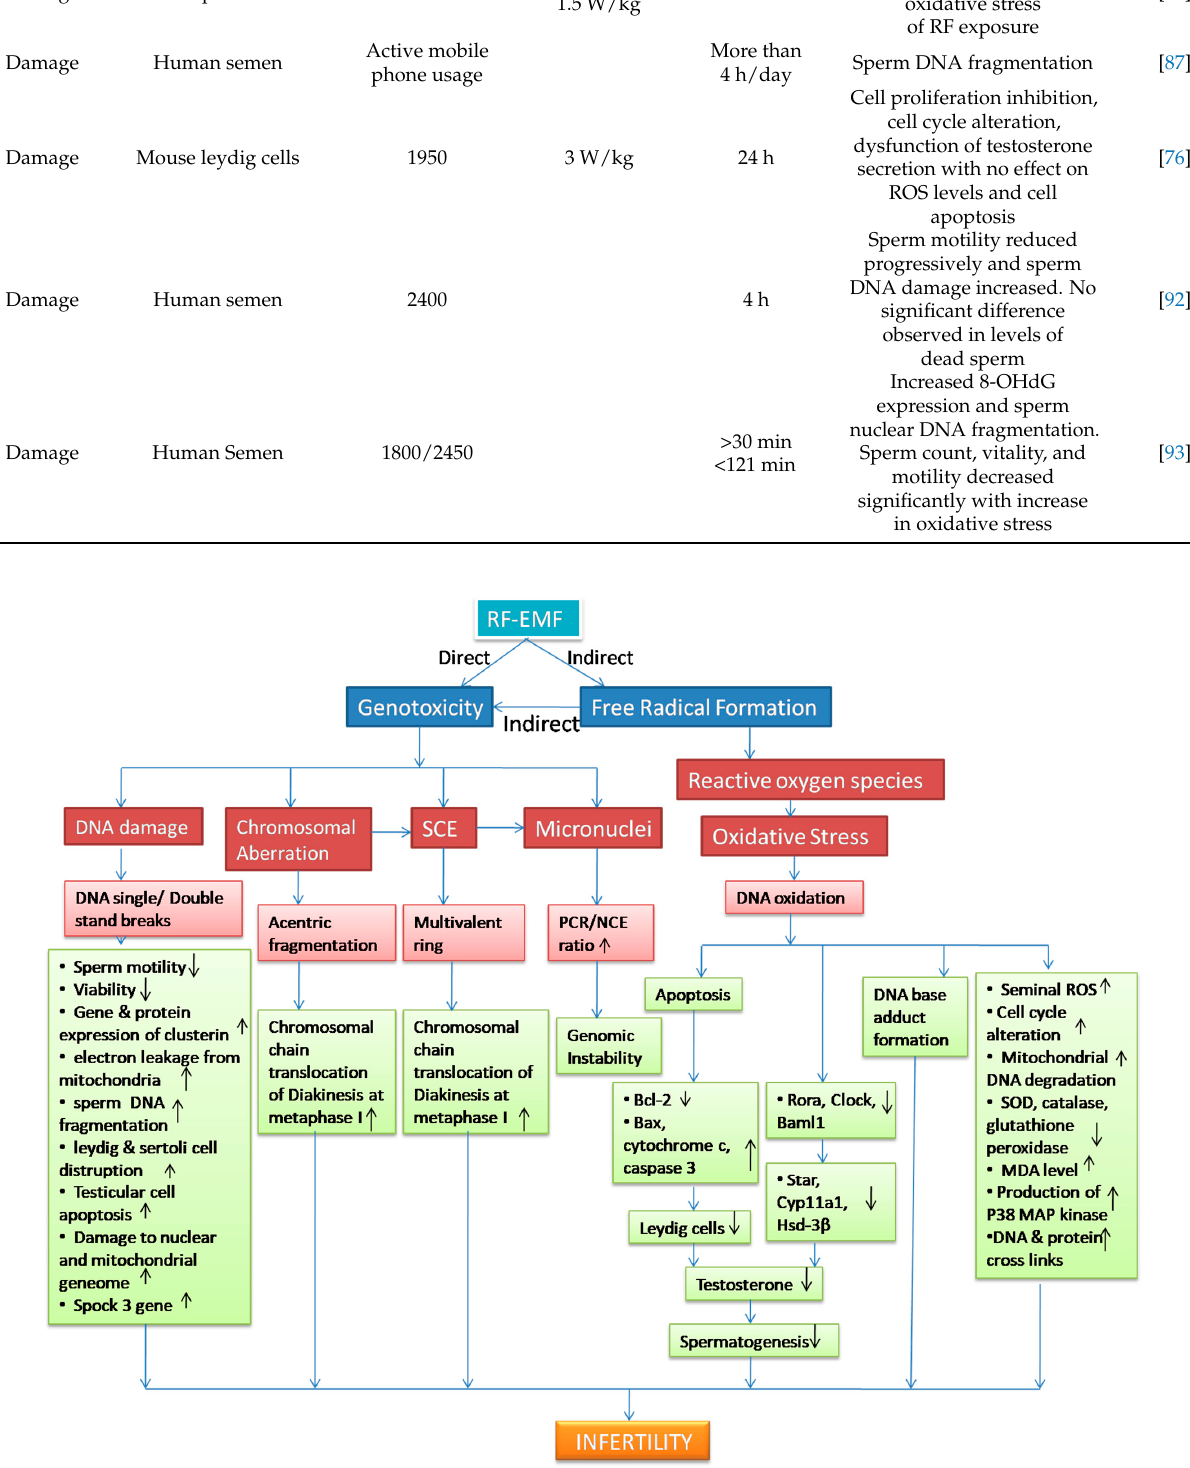
Figure 2. An overview of the genotoxic effects of RF-EMF on the male reproductive system. The figure suggests the probable radiation-induced damage, which may enhance ROS generation and genotoxic parameters such as DNA damage, micronuclei formation, chromosomal aberration, and SCE, leading to cause male infertility.